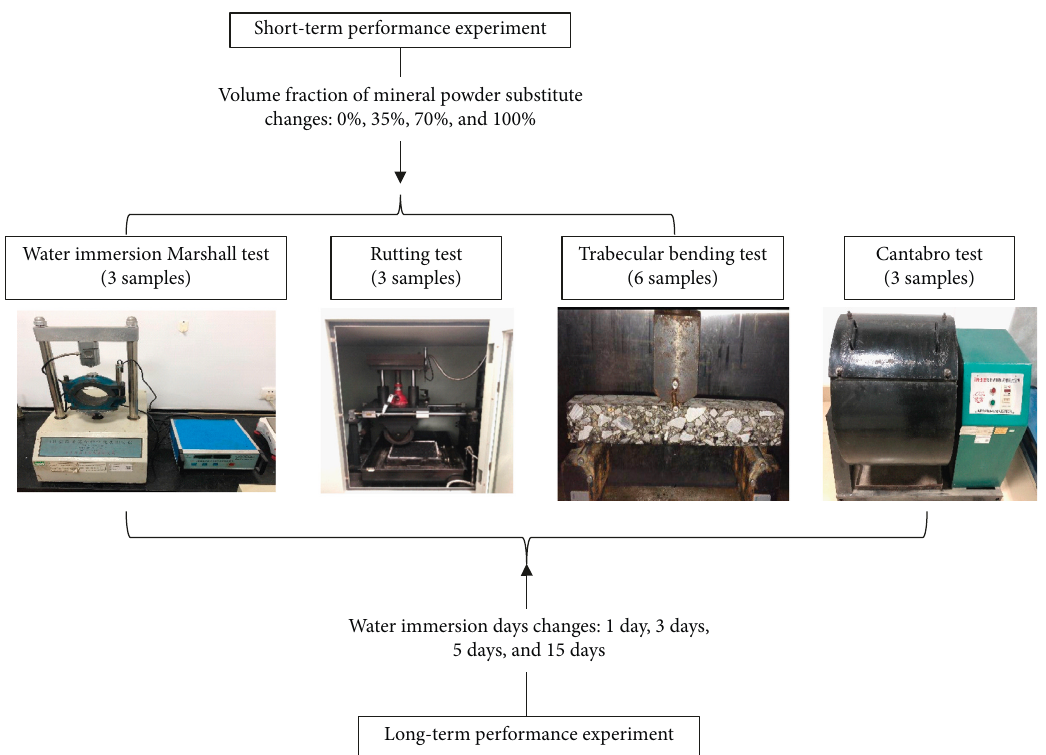
Figure 5: Flow chart of short- and long-term performance experiment.